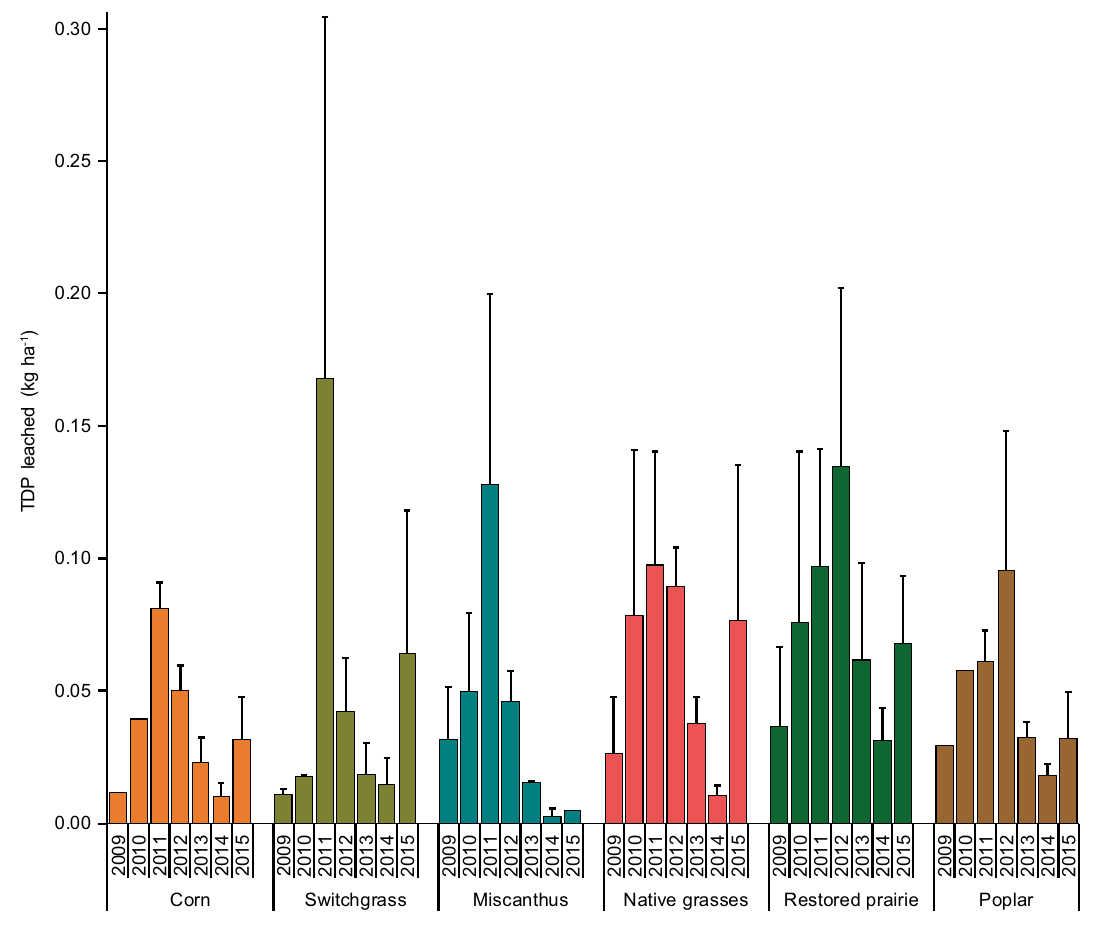
Figure 1. Annual leaching losses of total dissolved P (kg ha −1 ) from the different cropping systems. Each bar shows the standard error of the mean of four replicate plots. In some crops during the 2009 and 2010 crop- years, data were available for only one or two plots. The cropping-system means grouped across years are not significantly different (p > 0.05) in pairwise comparisons as determined by the Tukey honest significant difference test. Years refer to crop-years that extend from planting or emergence of the crop in the year indicated through the ensuing year until the next year’s crop planting or